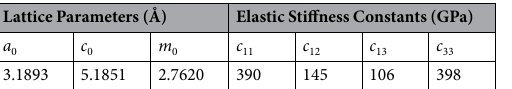
Table 1. Lattice constants and elastic stiffness coefficients of GaN in an unstrained state.